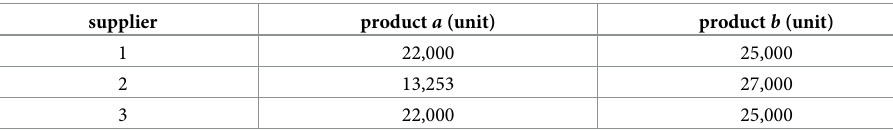
Table 16. The optimal order allocation from each